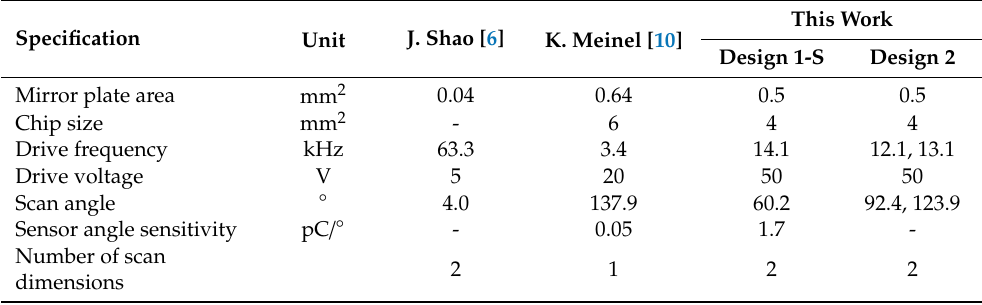
Table 7. Comparison of resonant driven micromirrors based on piezoelectric AlN in the current literature and this